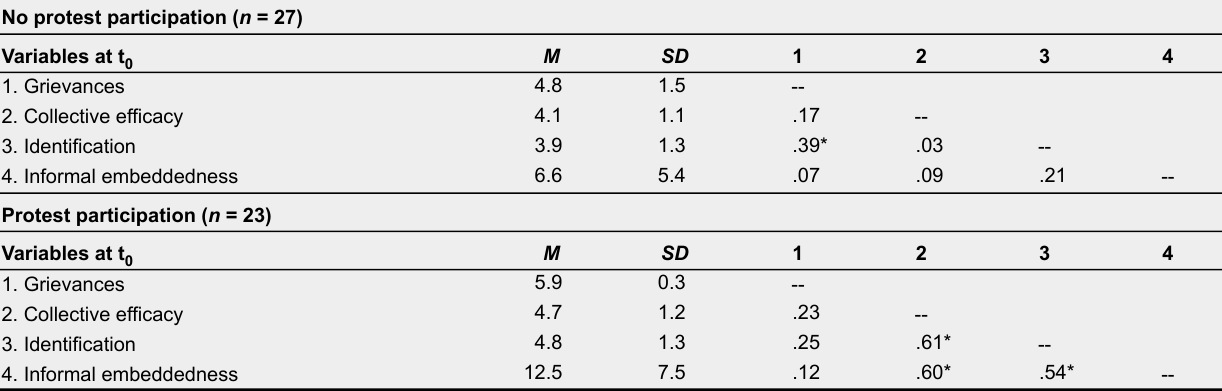
Means and standard deviations of participants that did (not) participate in protest, and correlations between the variables contributing to